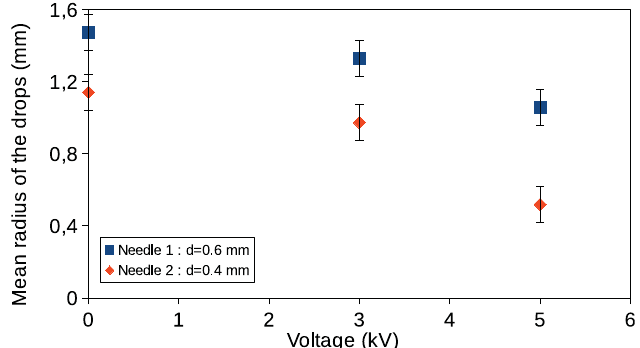
Fig. 5. In fl uence of the voltage D V and radius d /2 of the needle on the mean radius of generated drops. This mean radius is experimentally determined by collecting 50 drops and measuring their